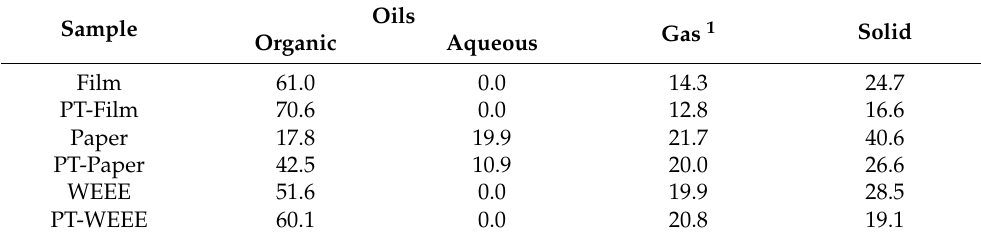
Table 6. Pyrolysis yields of the raw and pre-treated samples